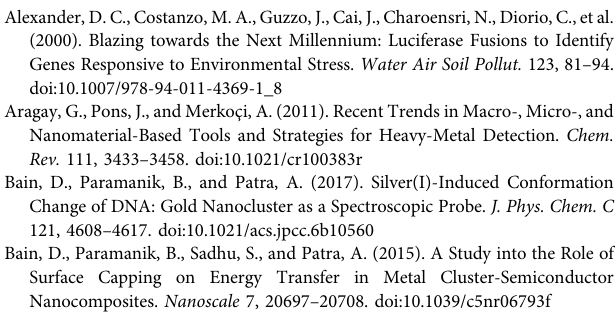
Frontiers in Chemistry |